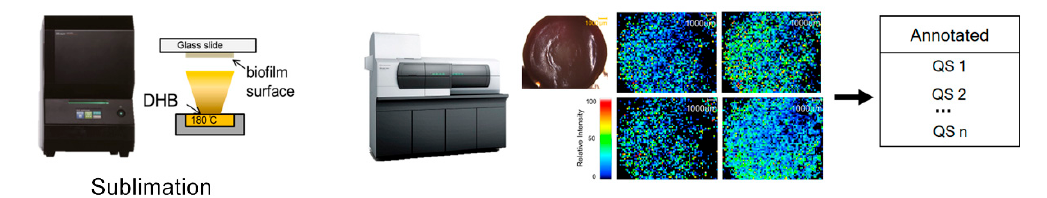
Figure 1. Workflow for cultivation and preservation of agar-based biofilms. ( A ) Cell cultivation. ( B ) Adherence and formation of bacterial biofilms onto the ITO glass slide surface. ( C ) Pretreatment of biofilms by flash-freezing and lyophilization. ( D ) Matrix sublimation and ( E ) MALDI-MSI analysis and metabolite annotation to distinguish ions specific to different biofilm regions.